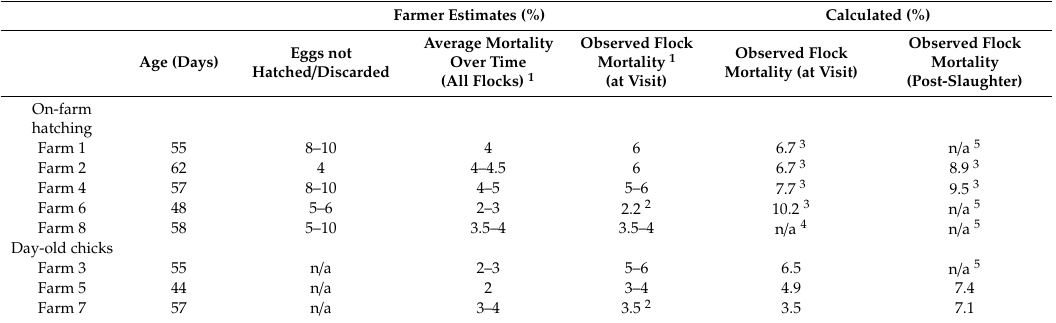
Table 3. Mortality (%) and eggs discarded (%) on Swedish organic broiler farms ( n = 8). Observed flock mortality (at visit) calculated with reference to original number of eggs / chicks and number of birds in flock at the time of visit (information provided by farmer estimates and / or computer production records). Observed flock mortality (post-slaughter) calculated with reference to original number of eggs / chicks and number of birds delivered to the abattoir. Farmer Estimates (%) Calculated (%) Observed Flock Average Mortality Observed Flock Observed Flock Mortality Over Time Mortality 1 Age (Days) Eggs not Hatched / Discarded Mortality (at Visit) (Post-Slaughter) (All Flocks) 1 (at Visit) On-farm hatching Farm